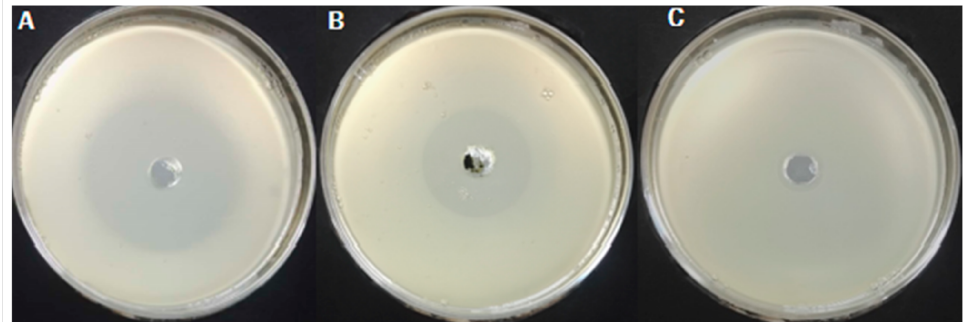
Figure 1. Antibacterial activity of ethyl acetate extract before and after elution by carbon column chromatography. ( A ) Treated by carbon column; ( B ) not treated by carbon column; ( C ) blank